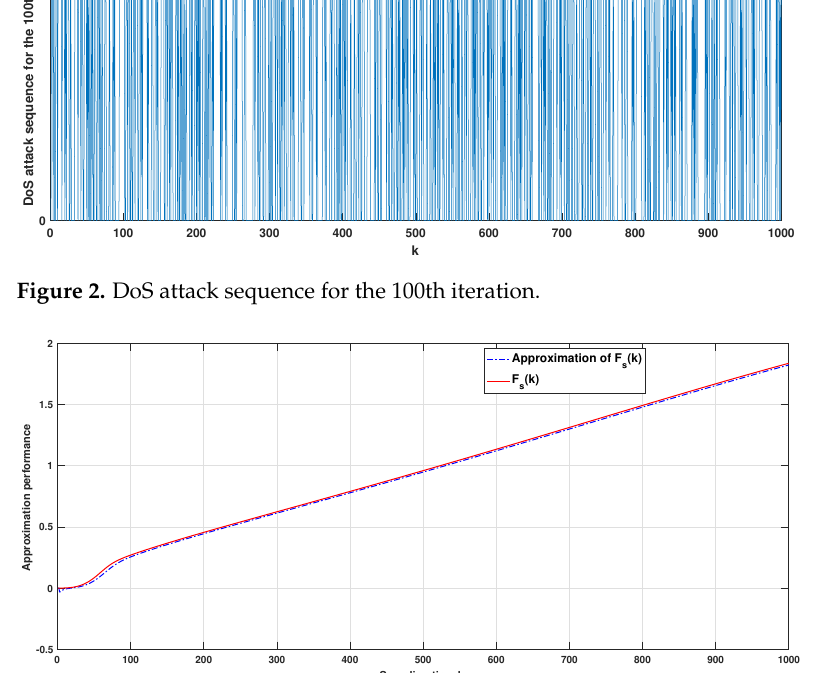
Figure 3. Sensor fault estimation.